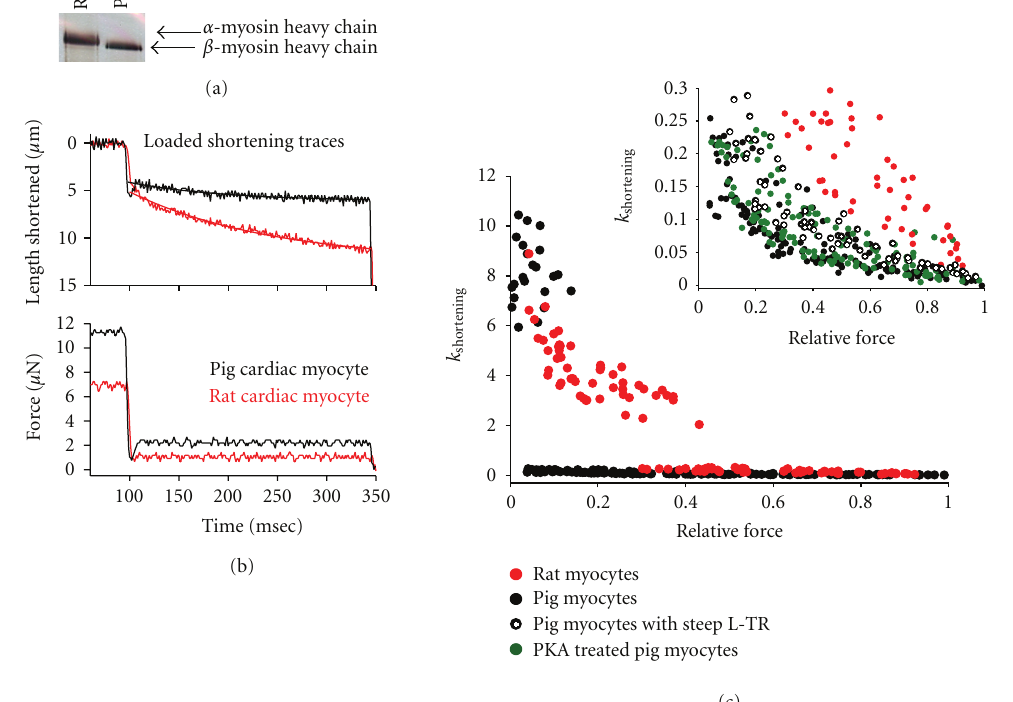
Figure 5: (a) Silver-stained gel showing the myosin heavy chain isoforms contained in a rat cardiac myocyte preparation compared to a pig cardiac myocyte preparation. (b) Representative length and force traces during a lightly loaded force clamp in a rat cardiac myocyte preparation (red) and a pig cardiac myocyte preparation (black) during a submaximal Ca 2+ activation. (c) Length traces exhibited con- siderably greater curvature (greater k shortening ) in rat myocytes compared to pig myocyte preparations at all relative loads. Inset in C shows an expanded plot of k shortening versus relative load, which clarifies slope constants below 0.30. Interestingly, PKA-mediated phosphorylation increased the curvature ( k shortening ) of length traces towards those of rat myocyte preparations. In addition, pig cardiac myocyte preparations that exhibited steep length-tension relationships (L-T R) also had more curved length traces. This is consistent with PKA-mediated phos- phorylation of myofilaments yielding greater responsiveness to changes in sarcomere length, in this case exhibited by greater shortening- induced cooperative